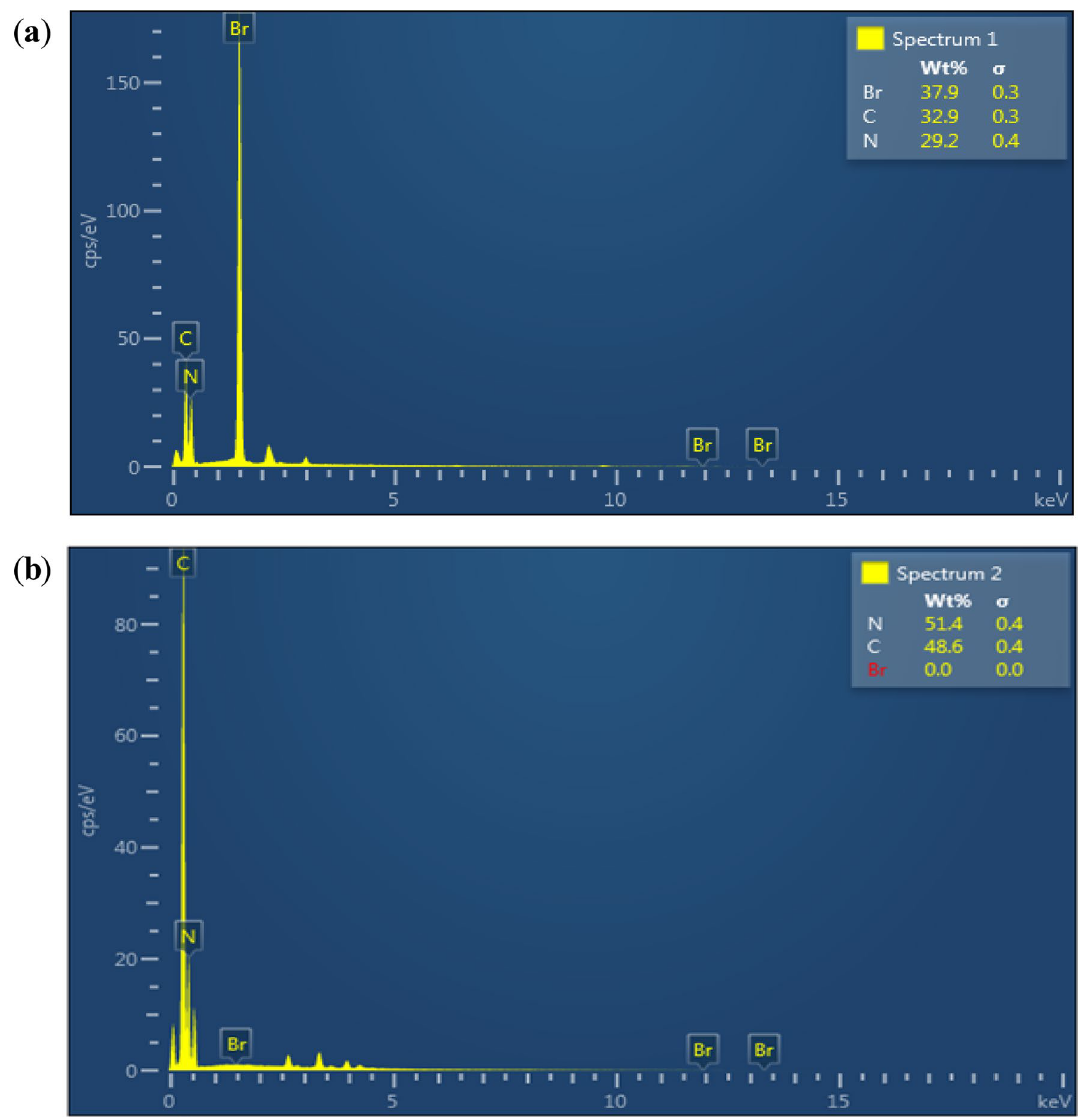
Figure 3. The EDX spectra of the Melamine@PrBr ( a ) and nano-ordered Melamine@TMG ( 1 , b